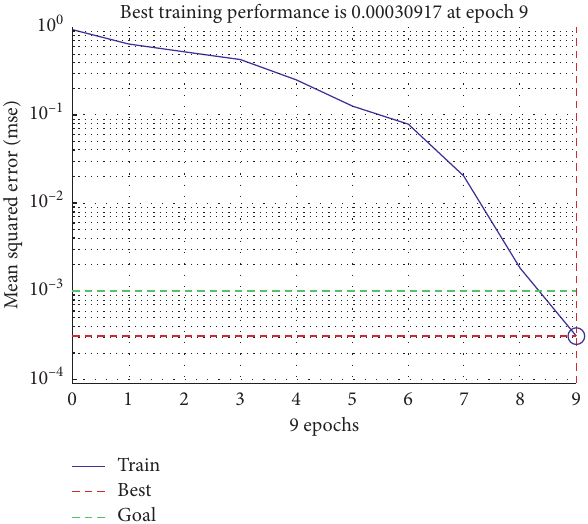
Figure 20: Network performance